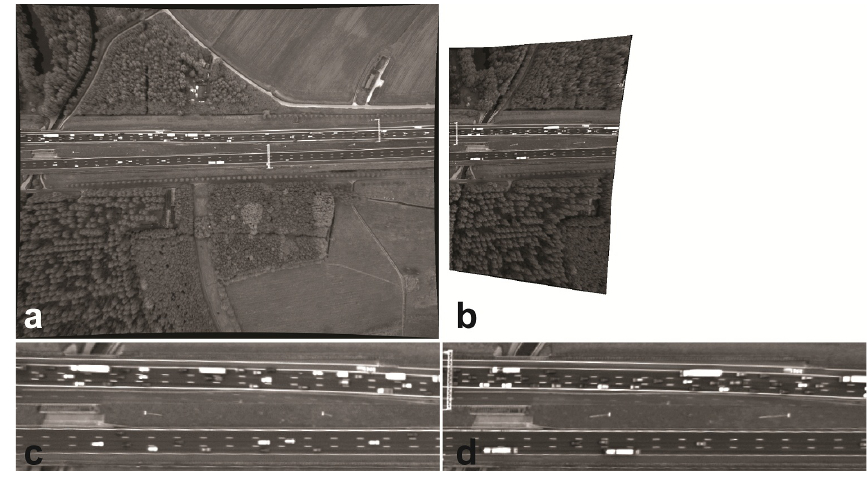
Figure 8. The registration result of the framework: ( a ) the reference image (first image) and ( b ) the transformed 1500 th image obtained with the registration procedure described in this paper. The non-overlapping area is removed from the 1500 th image. The road area is visualized in ( c ) and ( d ) in the same order. The geometric errors for the corresponding points on the road area are zero in pixel